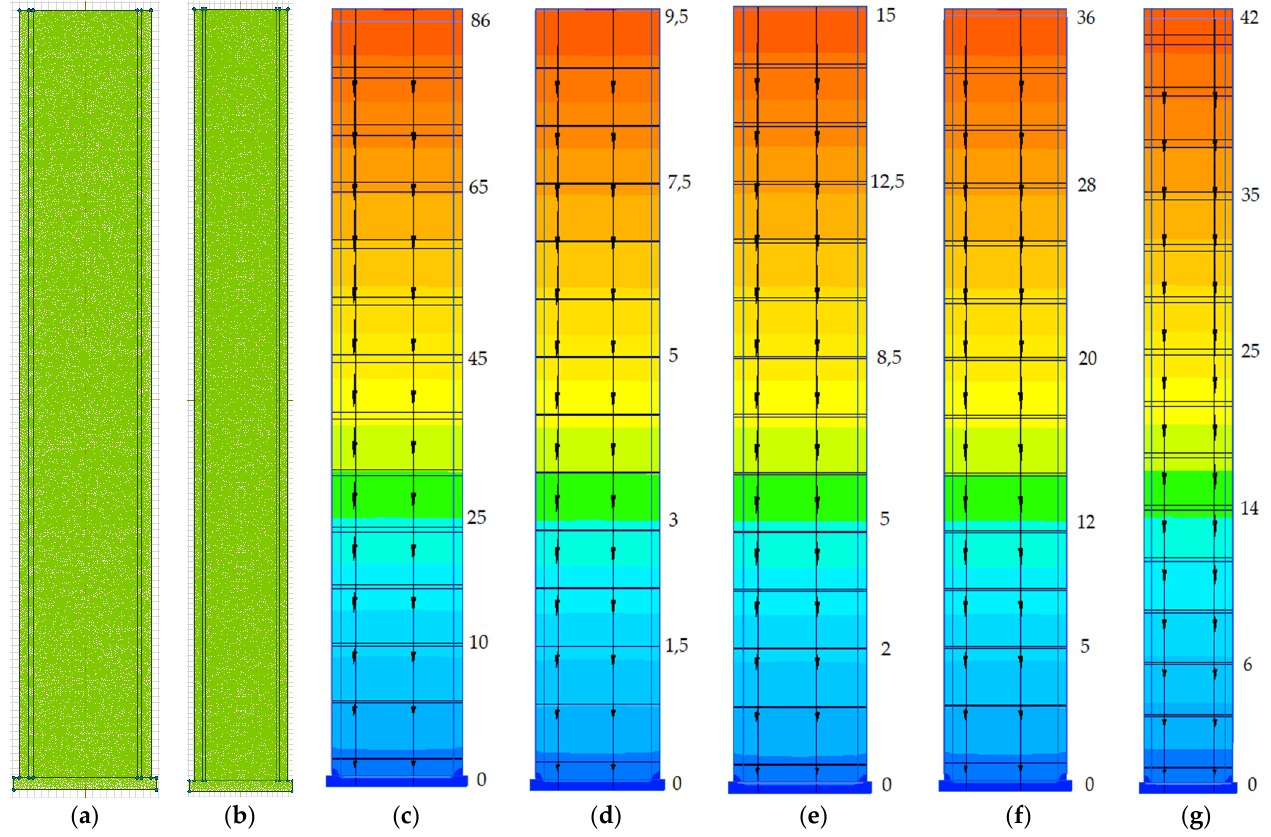
Figure 13. Scheme of samples with coatings No. 1.1–No. 1.3 ( a ) and No. 3.1 and No. 3.2 ( b ) in section by height and visualization of changed shape and displacement vectors under combined action of mechanical and thermal loads for samples No. 1.1 ( c ), No. 1.2 ( d ), No. 1.3 ( e ), No. 1.3 when reaching the limit state ( f ) and No. 3.1 and No. 3.2 ( g ).